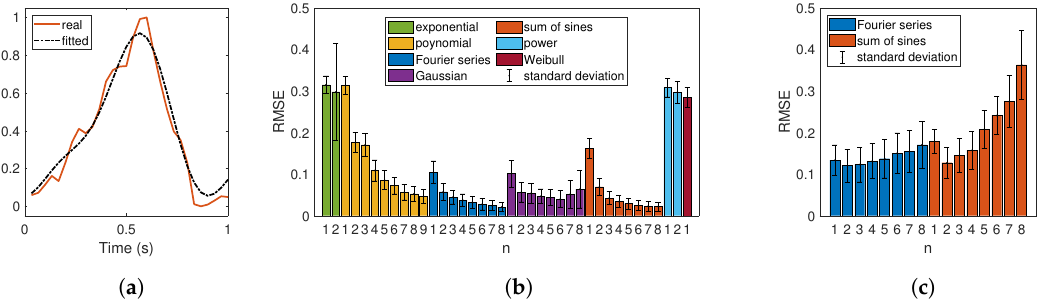
Figure 4. Fitting results. ( a ) Typical excerpt of a camera pulse wave extracted from the UBFC-RPPG dataset. Solid orange line: raw photoplethysmography (PPG) pulse wave. Dotted black line: fitted signal. ( b ) Results of the curve-fitting procedure (periodic and non-periodic models were tested). The RMSE is computed for each of the 62 pulse waves and its corresponding fitted-to-data approximation. The statistics for each tested method (each histogram bin) indicates that Fourier series and sum of sines are the most relevant models. ( c ) Each method (e.g., Fourier series with n = 1) contains 62 sets of a i and b i coefficients (one set of coefficients per PPG wave). We thus choose to respectively average the coefficients to produce a unique set of a i and b i coefficients for each method. Fourier series for n = 2 correspond to the method that gives the lowest